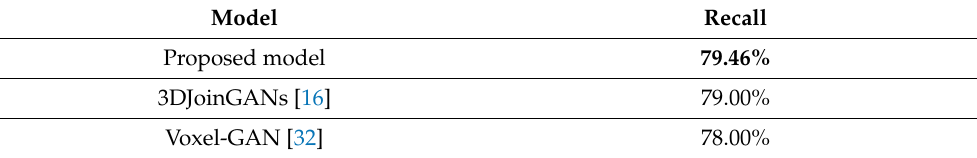
Table 5. The performance of the proposed model using the training set of the ISLES-2018